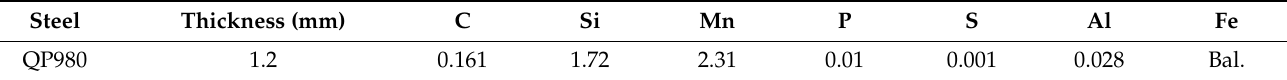
Table 1. Chemical compositions of steel sheets used in the study (wt %). Steel Thickness